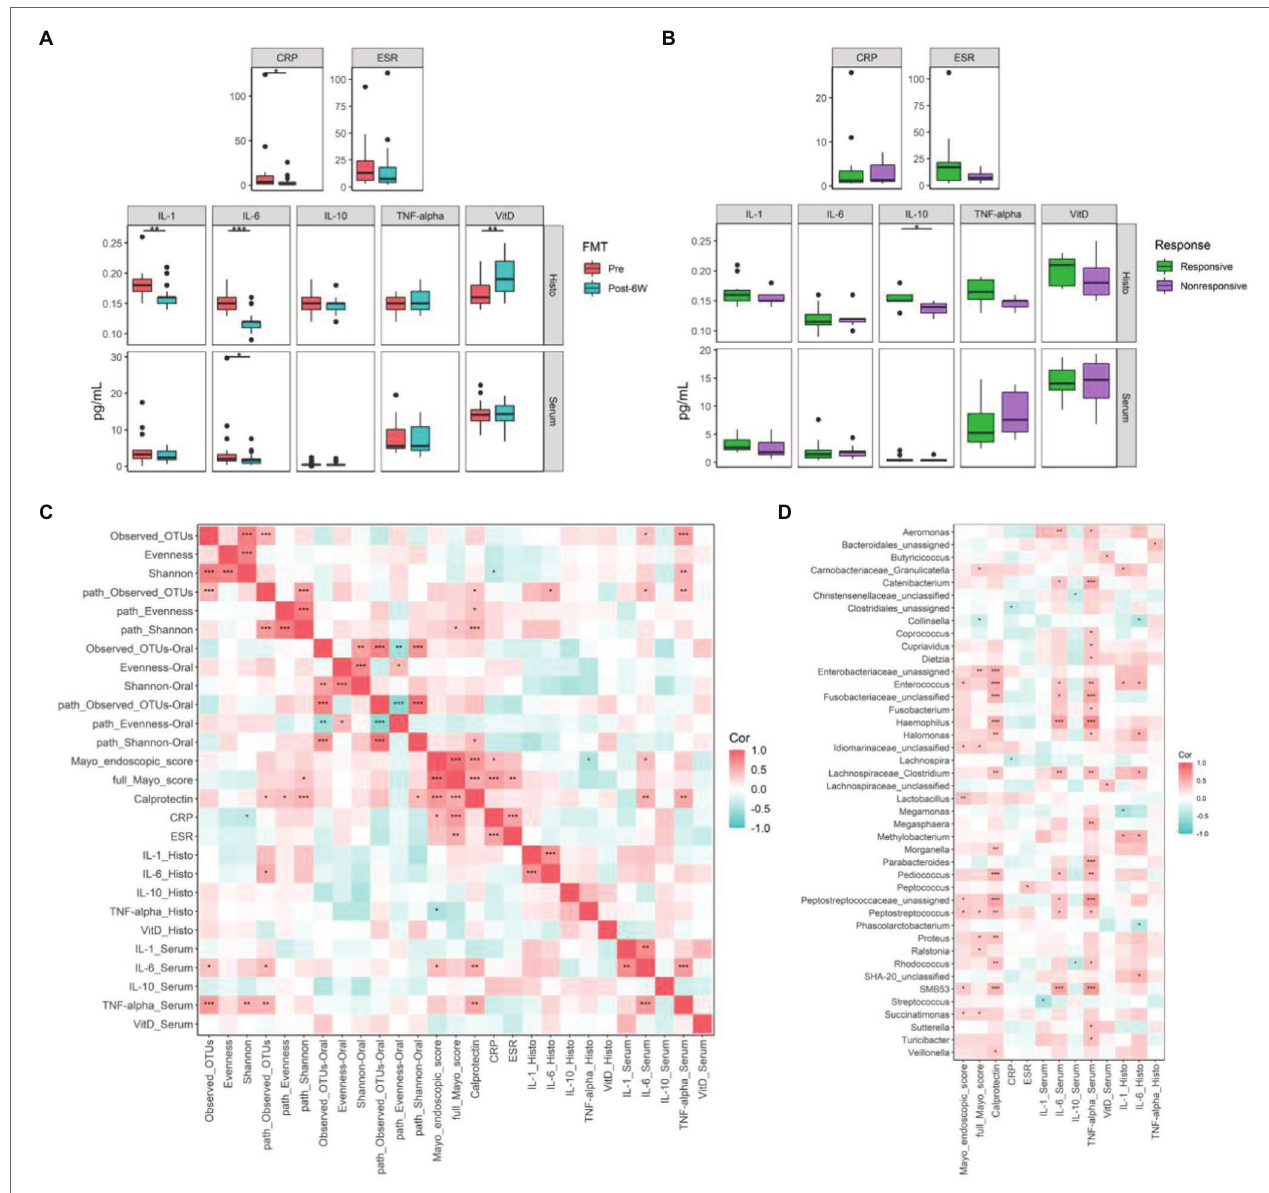
FIGURE 4 | The biomarkers related to ulcerative colitis (UC) and their correlations with gut microbiota. (A) The biomarkers levels of all patients before and 6 weeks after FMT. (B) The biomarkers levels of responsive and nonresponsive patients 6 weeks after FMT. (C) The correlation coefficients between biomarkers and microbial diversities. (D) The correlation coefficients between biomarkers and gut microbiota at genus level. Boxplots present the median and interquartile range (25–75th percentiles) for each group with whisker length equal to 1.5 interquartile range. The colors show the group of patients. Statistically significances are also indicated: * p < 0.05, ** p < 0.01, and *** p < 0.001. The Spearman correlation coefficients were calculated and labeled in the figure. Statistically significances are also indicated: * p < 0.05, ** p < 0.01, and *** p <